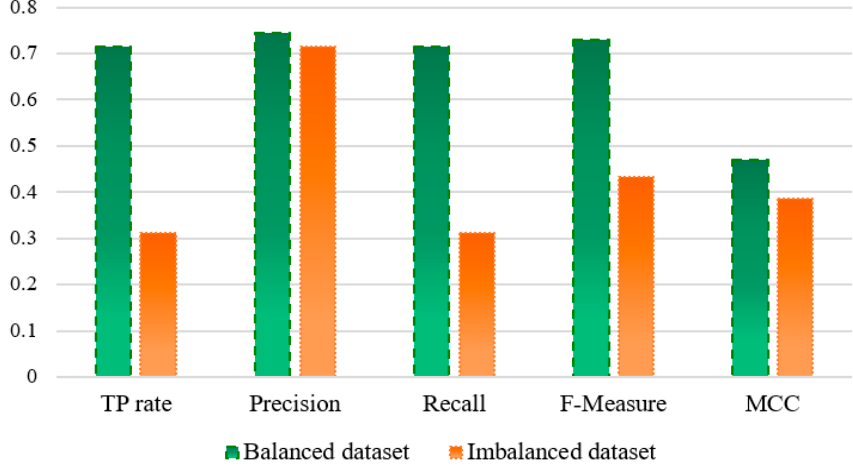
Figure 3. Comparison of the balanced dataset with imbalanced dataset.